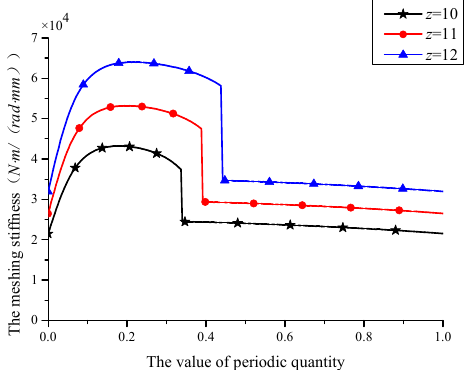
Figure 24. Influence rule of z on meshing stiffness.